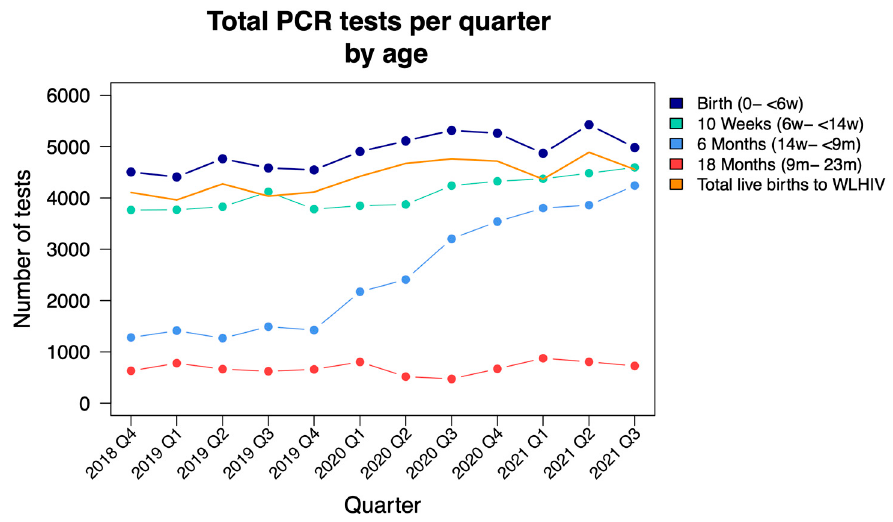
Figure 1. HIV PCR tests performed quarterly from October 2018 to September 2021, stratified by age; NICD data (d = days; w = weeks; m = months; WLHIV = women living with HIV). * Total birth tests performed are higher than the total live births to WLHIV, likely due to a combination of under-reporting of the DHIS indicator and repeat HIV PCR tests performed in the first 6 weeks of life.